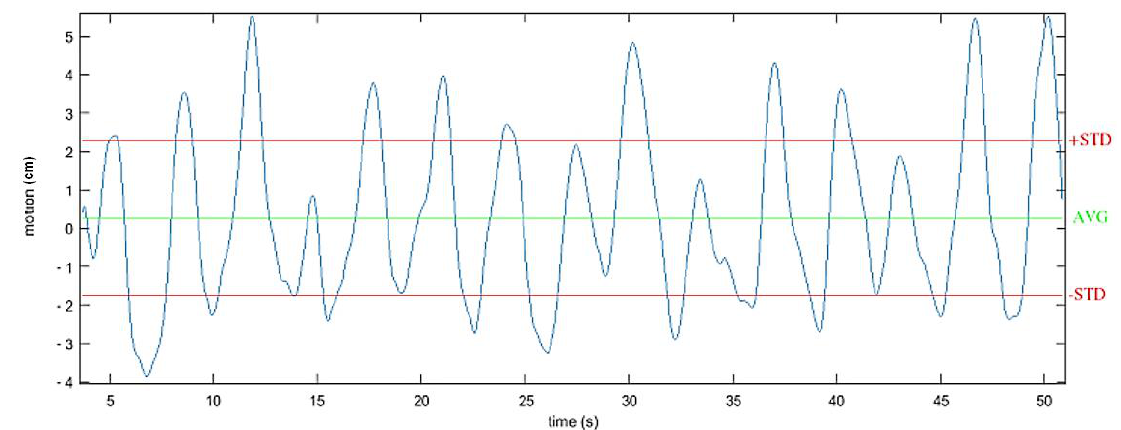
Figure 7. Example of one recording of the vertical displacement of the center of mass during walking. Estimated by double integrating the filtered acceleration from an IMU located at the second sacral vertebra level.